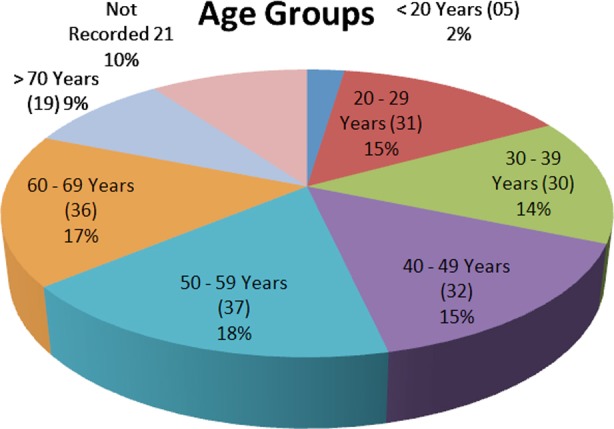
Age of Patients.